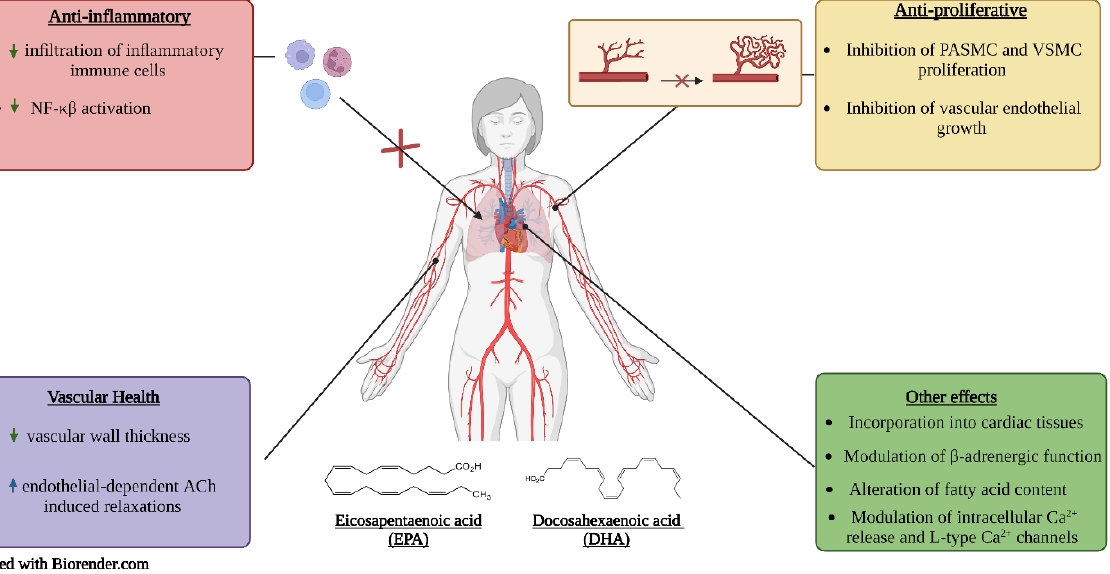
Figure 3. Proposed mechanisms of action of EPA and DHA. Upward facing arrows indicate an increase in activity, while downward facing arrows indicate a decrease in activity.